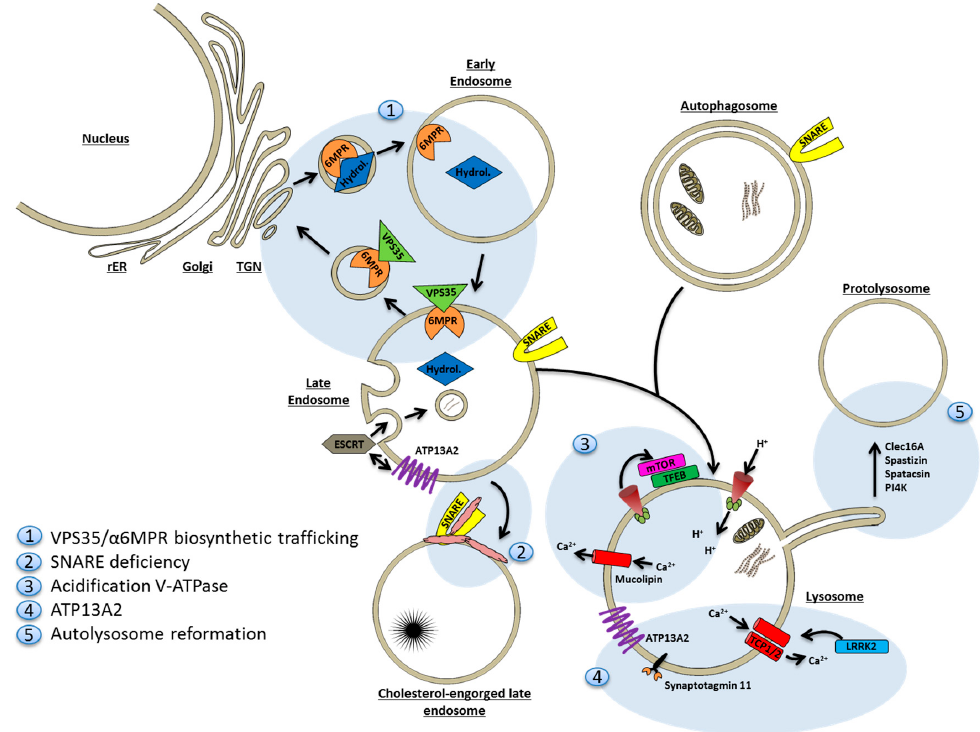
Figure 3. Mechanisms of lysosomal deficiency. (1) Normal delivery of the 50+ lysosomal acid hydrolases can become compromised by the lack of individual functional hydrolases or more generally by the derangement of Trans-Golgi network (TGN)-endosome trafficking affecting retromer (VPS35 mutations) function and its client Mannose-6-phosphate receptor (M6PR), the receptor for sorting of many hydrolases from TGN to the endosome; (2) In some lipid storage diseases SNAREs, required for entry of autophagosomes into the endolysosomal system, become “trapped” in cholesterol-enriched microdomains of lipid-laden late endosomes/lysosomes; (3) Proton and calcium fluxes are also affected in Alzheimer’s Disease (AD) and Parkinson’s Disease (PD). Presenilin (PSEN) mutations compromise sorting and/or function of the v-Adenosine Triphosphatase (ATPase) leading to relative alkalisation of the lysosome with reduced proteolysis. PSEN mutations also indirectly affect calcium efflux through mucolipin channels. The lysosomal phenotype contributed by Leucine-rich repeat kinase 2 (LRKK2) mutations can be rescued by Two-pore channel (TCP2) calcium channel knock-down; (4) ATP13A2 positively regulates ILV formation in late endosomes, and ATP13A2 mutations confer reduced luminal acidification and proteolysis that can be rescued by overexpression of synaptotagmin 11; (5) Autolysosome reformation is inhibited by gene products associated with neurological disease including clec16A, spastizin and spatacsin, and